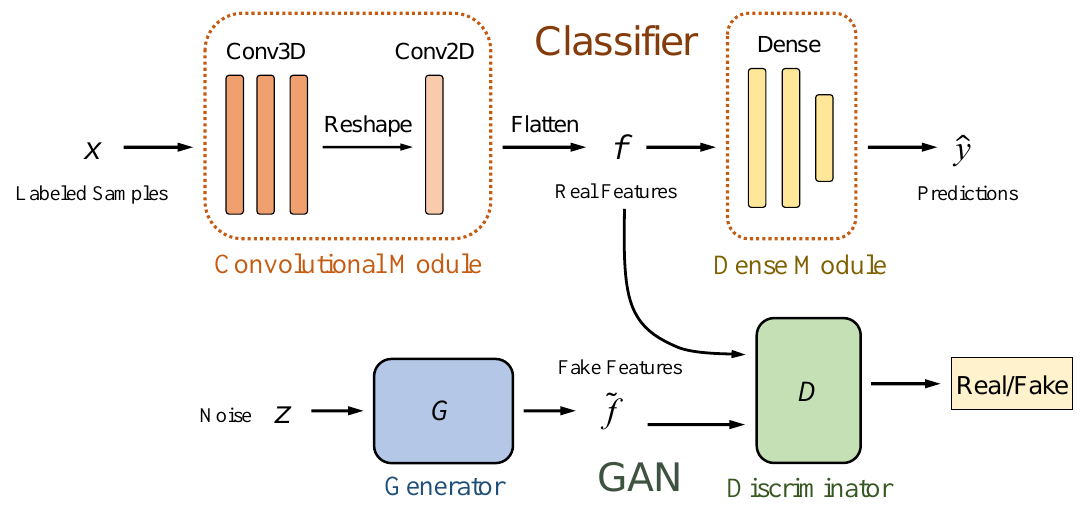
Figure 1. Adversarial learning with high-level features. The process involves two distinctive components: (i) a classifier that is divided into a convolutional module and a dense module, and (ii) a generative adversarial network (GAN) with two subnetworks: a feature generator G and a feature discriminator D . The convolutional module learns representative high-level features f from labeled hyperspectral samples x . The dense module transforms f into final predictions ˆ y . The GAN provides adversarial learning with the high-level features. Specifically, G maps noise z into high-level feature space to generate fake high-level features ˜ f . D learns to distinguish f (treated as ‘Real’) from ˜ f (treated as ‘Fake’). Trained with both the real and the fake high-level features, D captures the feature variability of hyperspectral images and yields a powerful and generalized discriminative capability. We leverage well-trained D as the acquisition heuristic for active learning to measure whether an unlabeled sample is worth querying or not.